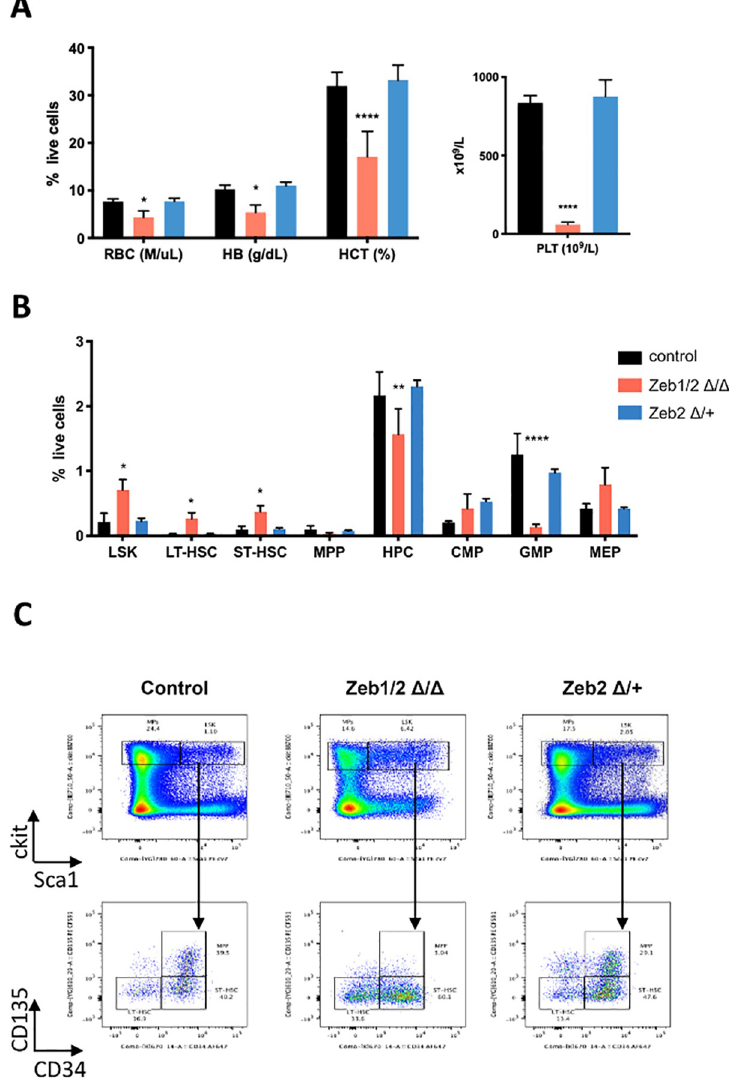
Fig 5. Maintenance of a single Zeb2 wt allele rescues PB cytopenia and severe differentiation defects in Zeb1/2 DKO HSPCs. (A) Hemavet analysis showing that maintenance of a single wt Zeb2 allele in Zeb2 Δ /+ , Zeb1 Δ / Δ (abbreviated Zeb2 Δ /+ ) mice can rescue the HCT defects observed in Zeb1/2 Δ / Δ DKO including RBC and HB levels as well as normalization of PLT (right) numbers. (B) Flow cytometric analysis of HSPCs from the BM showing that presence of single Zeb2 allele in Zeb2 Δ /+ mice can also normalize LSK, LT-HSC (lin − cKit + Sca1 + CD34 − Cd135 − ), ST-HSC (lin − cKit + Sca1 + Cd34 + Cd135 − ), HPC (lin − cKit + Sca1 − ), CMP, GMP, and MEP HSPC numbers compared to defects observed in Zeb1/2 Δ / Δ DKOs. (C) Representative flow cytometry plot of HSPCs. Bars in panels represent mean ± SD, n = 5 per group; � p < 0.05; �� p < 0.01; ���� p < 0.0001, Dunnett multiple comparisons test. Raw data behind graphs are included in D of S1 Data. DKO, double knockout; HB, hemoglobin; HCT, hematocrit; HSPC, hematopoietic stem and progenitor cell; PB, peripheral blood; PLT, platelet; RBC, red blood cell; wt, wild-type. expressed genes (DEGs) between these 4 separate genotypes by RNA-seq ( N = 3/genotype). This time point was also chosen given the severe lethal phenotype observed in Zeb1/2 Δ / Δ mice 10 days post-tamoxifen. Using the RNA-seq data obtained from Zeb1 Δ / Δ , Zeb2 Δ / Δ , and Zeb1/ 2 Δ / Δ KO LSK cells and bioinformatics analysis, we were able to quantify the degree to which Exon 6 of Zeb1 and Exon 7 of Zeb2 were deleted and the residual amount of unrecombined